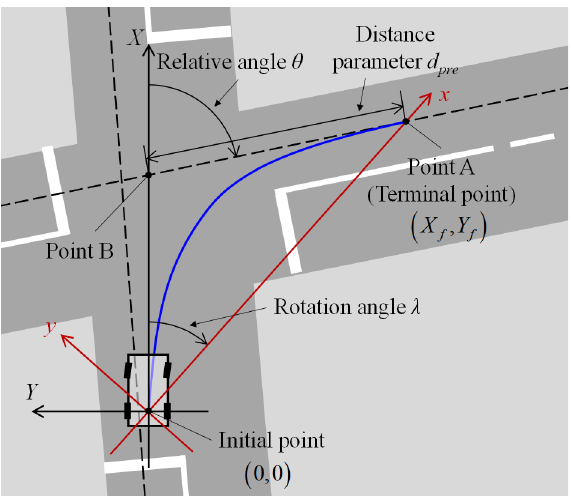
Figure 4. Parameter definitions for Triclothoidal curve